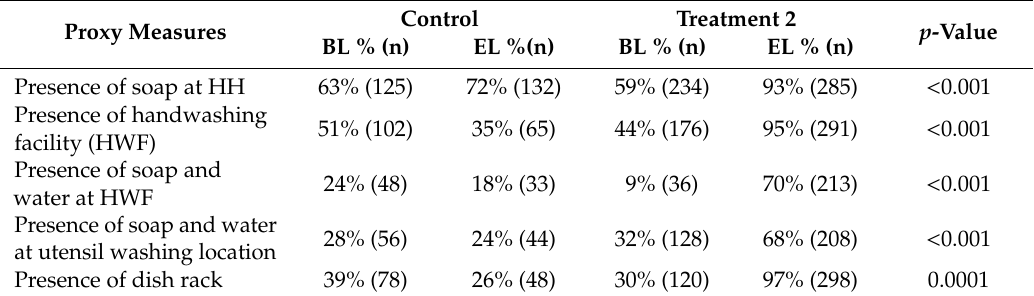
Table 2. Proxy measures compared between Control and Treatment 2 at baseline (2017) and end line (2018).